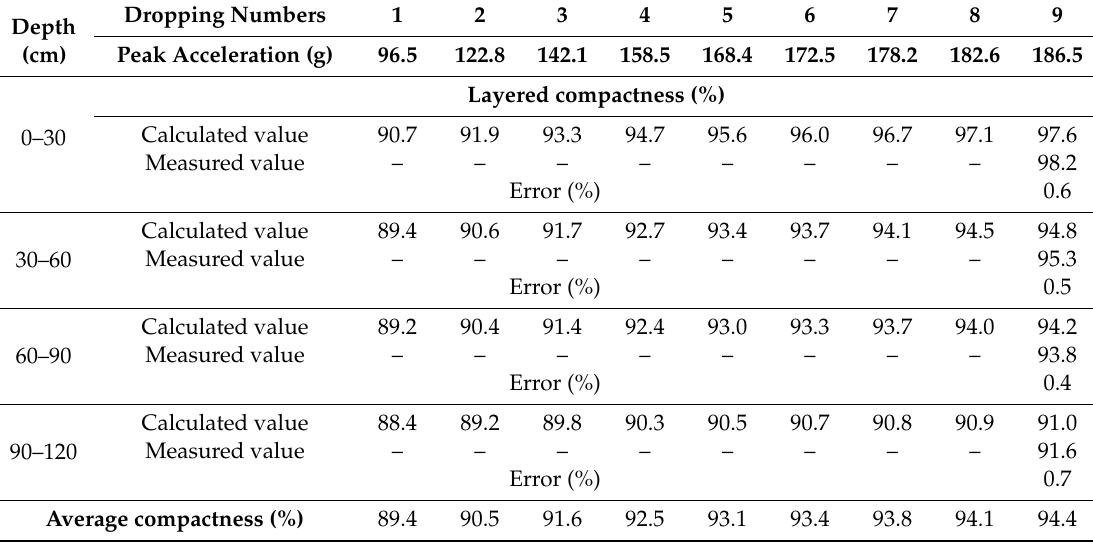
Figure 15. Subgrade construction of bid section-06 of Huangling-Yan’an Expressway: ( a ) layered filling; ( b ) laying up tamping point; ( c ) reinforcing subgrade; ( d ) measuring compactness. Table 4. Measured and calculated values of layered